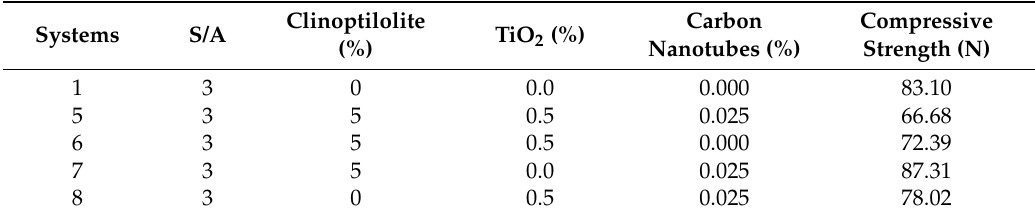
Table 6. Resistance to compression of systems with more additives.